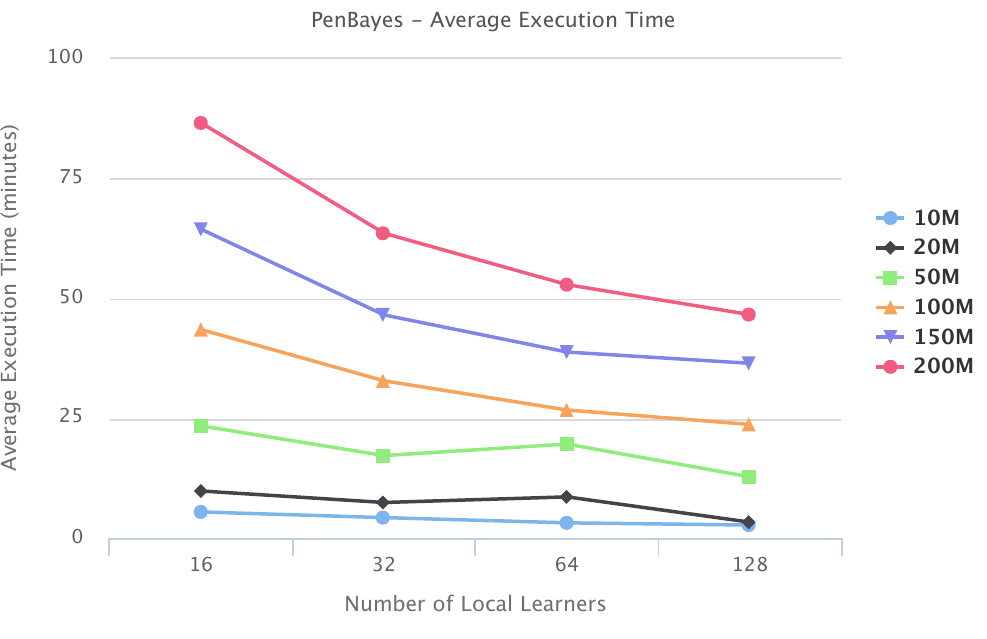
Figure 19. Insurance Set Execution Time vs. Number of Local